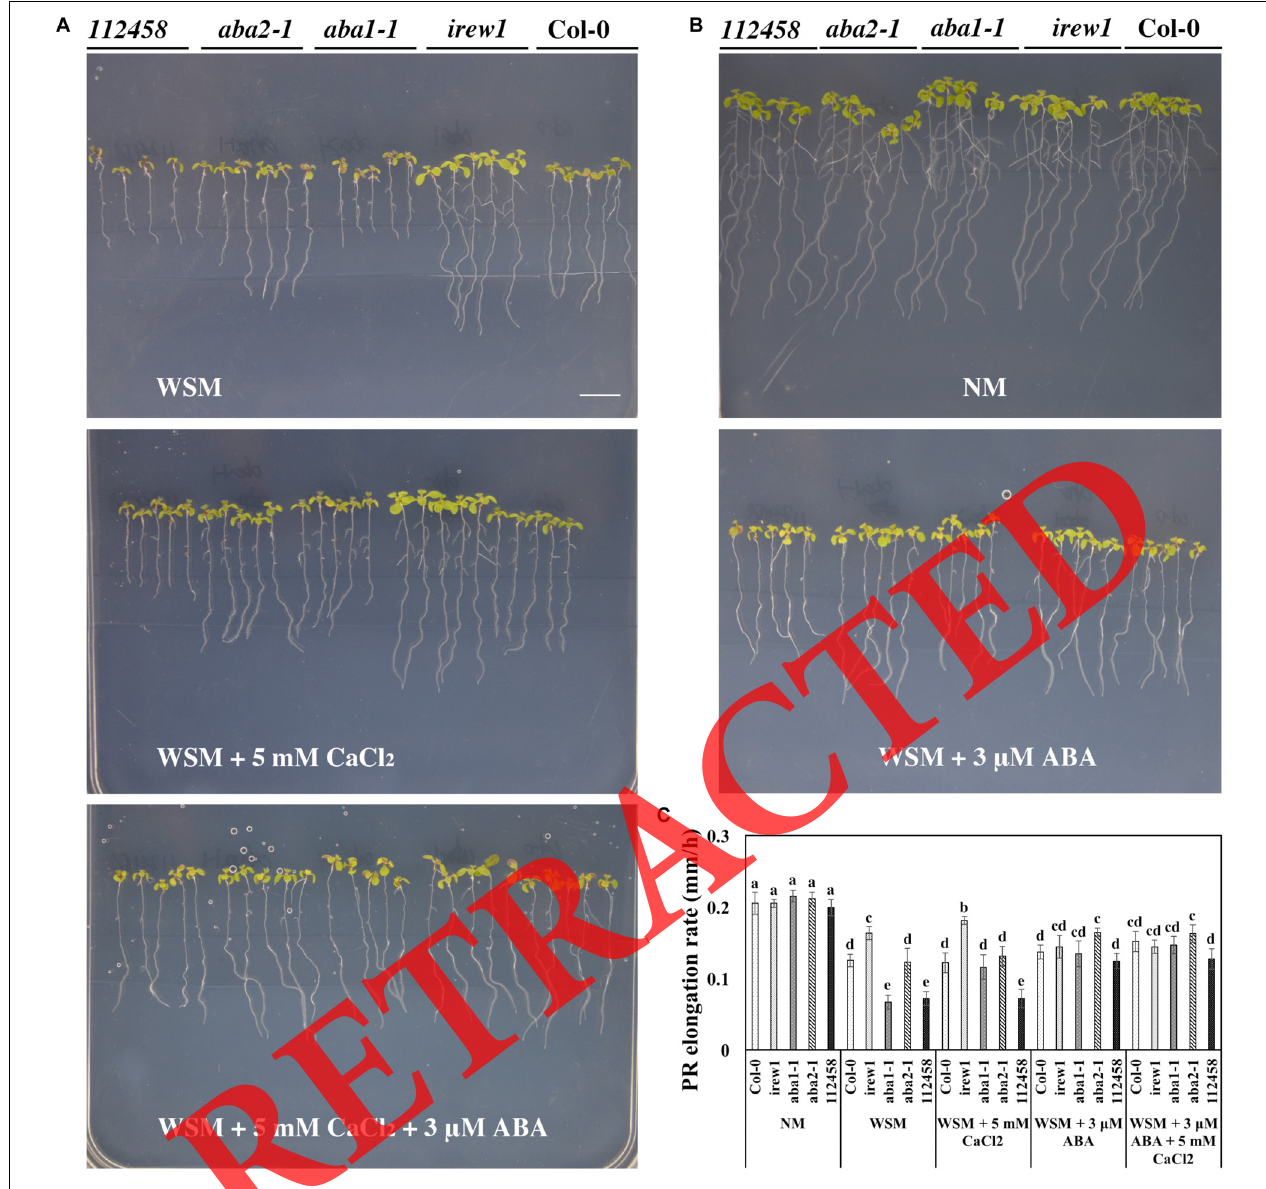
FIGURE 6 | Characterization of Col-0, irew1 , aba1-1 , aba2-1 , and 112458 mutants’ seedlings grown on NM and WSM in the presence of Ca 2 + and ABA. (A) Growth phenotype of Col-0, irew1 , and aba1-1 , aba2-1 , 112458 mutants’ seedlings grown on WSM in the absence or presence of 5 mM Ca 2 + or 5 mM Ca 2 + and 3 µ M ABA at 10 days after germination (dag), for vertical growth lasting 5 days after which germinated for 5 days. (B) Growth phenotype of Col-0, irew1 , and aba1-1 , aba2-1 , 112458 mutants’ seedlings grown on NM and WSM in the presence of 3 µ M ABA at 10 days after germination (dag), for vertical growth lasting 5 days after which germinated for 5 days. (C) Measurement of primary root (PR) elongation rate of Col-0, irew1 , and aba1-1 , aba2-1 , 112458 mutants’ seedlings shown in panels (A) and (B) . The values are means, and error bars show ± SD of five biological replicates from three independent experiments ( n = 15). Different lowercase letters represent significant difference at P < 0.05, as determined by a Tukey’s post hoc